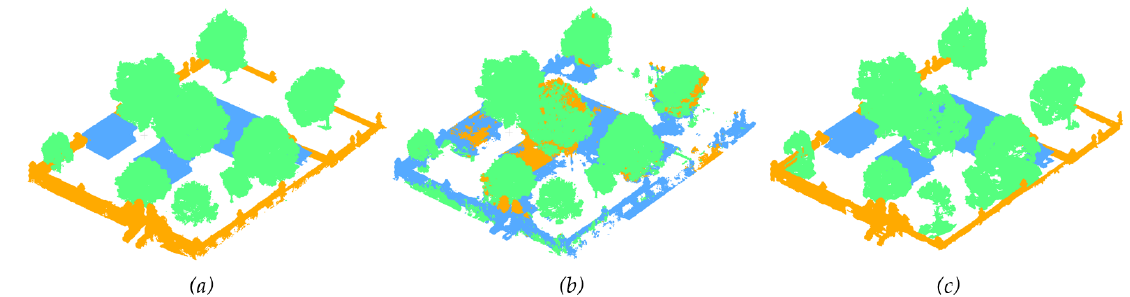
Figure 6. Visual comparison of the point cloud segmentation process: ( a ) displays the manual classification used as reference, ( b ) the results of the Metashape automatic classification, and ( c ) the results from M_HERACLES. The color blue denotes the ‘buildings’ class, orange the ‘walls’ class, and green the ‘trees’ class.